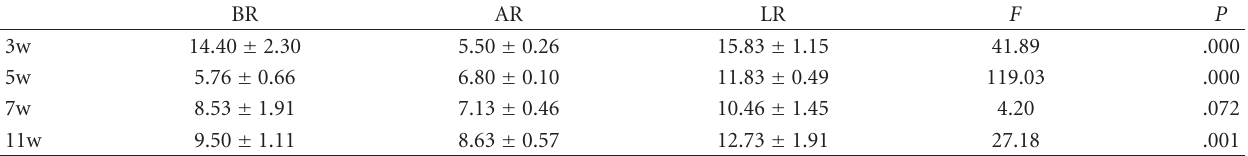
Table 6: The express level of the CD3 + CD4 + CD25 + T cells of each group in di ff erent development stage (Mean ± SD) ( N = 5). BR AR LR F P 3w 14.40 ±